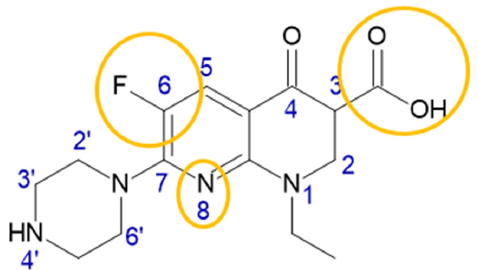
Figure 1. Structure of enoxacin. The figure shows the fragments of the structure responsible for the regulation of miRNA expression. regulation of miRNA